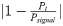
Profit taking mechanism.If after observing a signal to buy, the prices rise enough (in our case this is defined as the moment at which |1-PtPsignal| exceeds a parameter γ), the technical agent will proceed to enter a sell market order. This practice is commonly used by traders to insure an immediate profit.